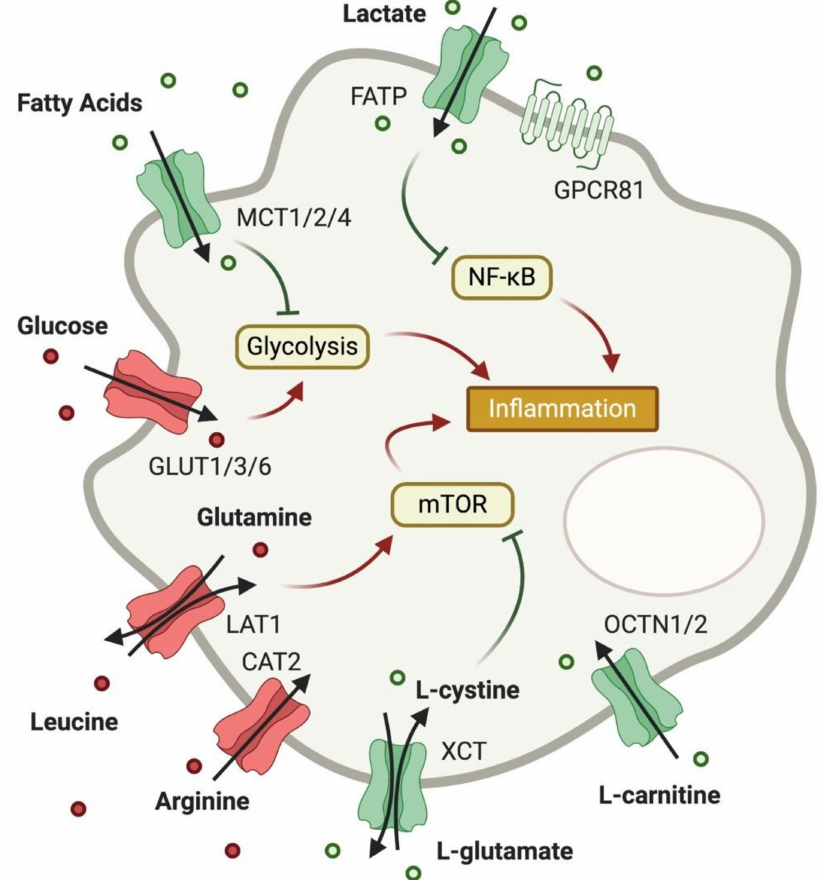
Figure 2. Expression of metabolite transporters on macrophages and their impact on macrophage function. As in T cells, glucose uptake is increased in pro-inflammatory macrophages, and AA uptake boosts mTOR activity. Cystine and glutamate, however, can limit mTOR activation through generation of cysteine and glutathione. Carnitine also exhibits anti-inflammatory potential, while FA uptake can limit glycolysis. Unlike in T cells, lactate uptake into macrophages is considered to be anti-inflammatory through inhibition of NF- κ